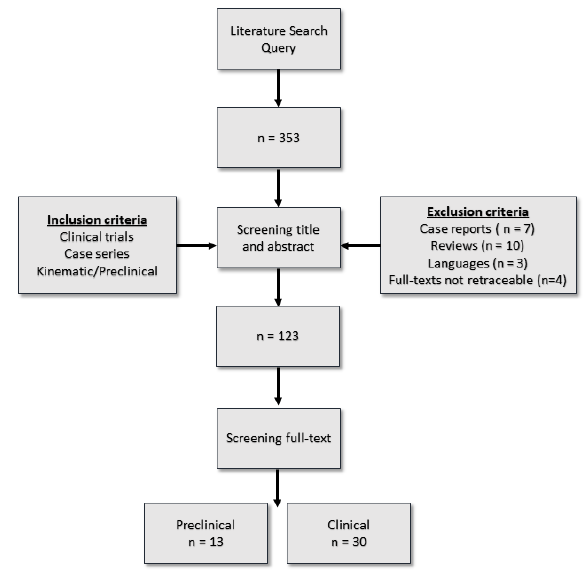
Figure 1. Systematic literature review flowchart.